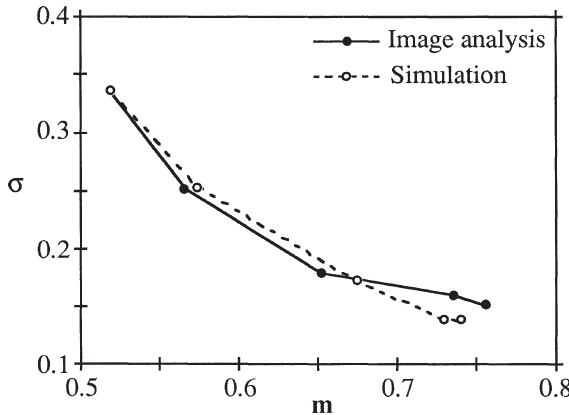
Fig. 8. Position of the normalized values of m and σ for the different distributions. The plain curve (—) represents the results of the image analysis. The dashed curve (- - -) represents the results of the simulation process. of which it is an abstraction. Our model uses a rigid two-dimensional tessellation, but cell sizes and changes in cell sizes are